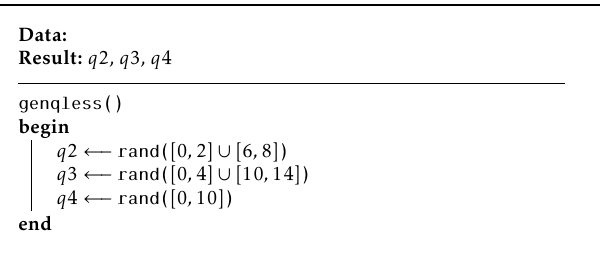
Algorithm 7: genqless : Generate q to have fewer possible instructions